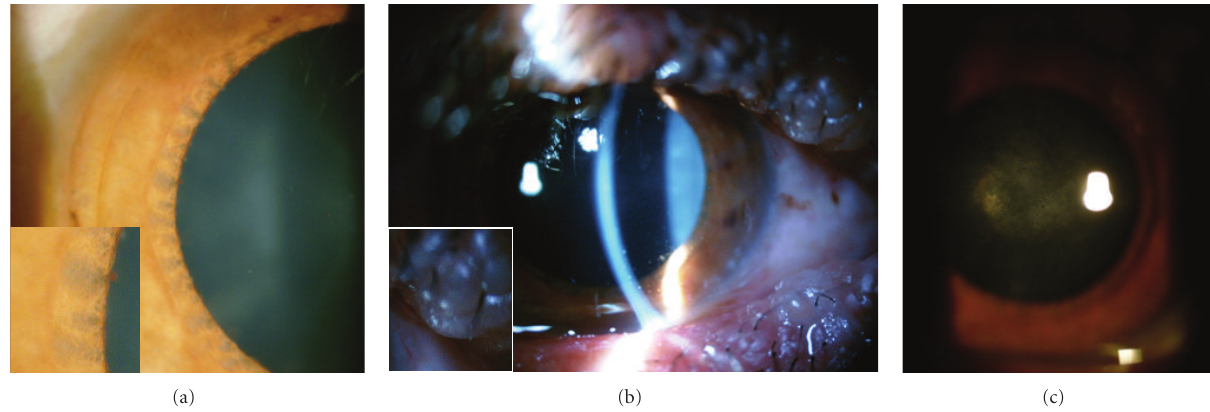
Figure 2: (a) Di ff use iris atrophy. (b) Di ff use keratic precipitates. (c) Posterior subcapsular cataract.